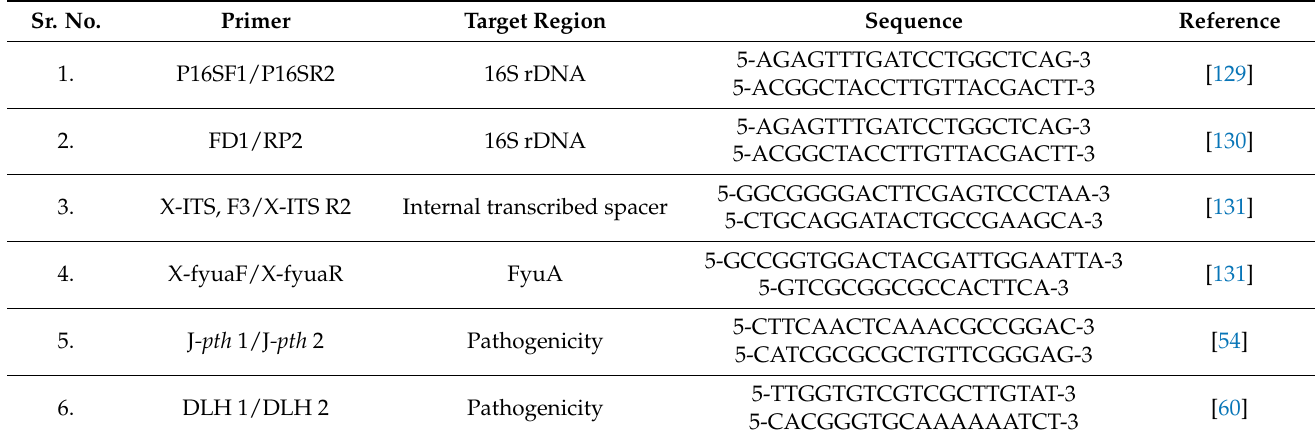
Table 2. List of various primers used for the detection of Xanthomonas citri pv. citri . Sr.